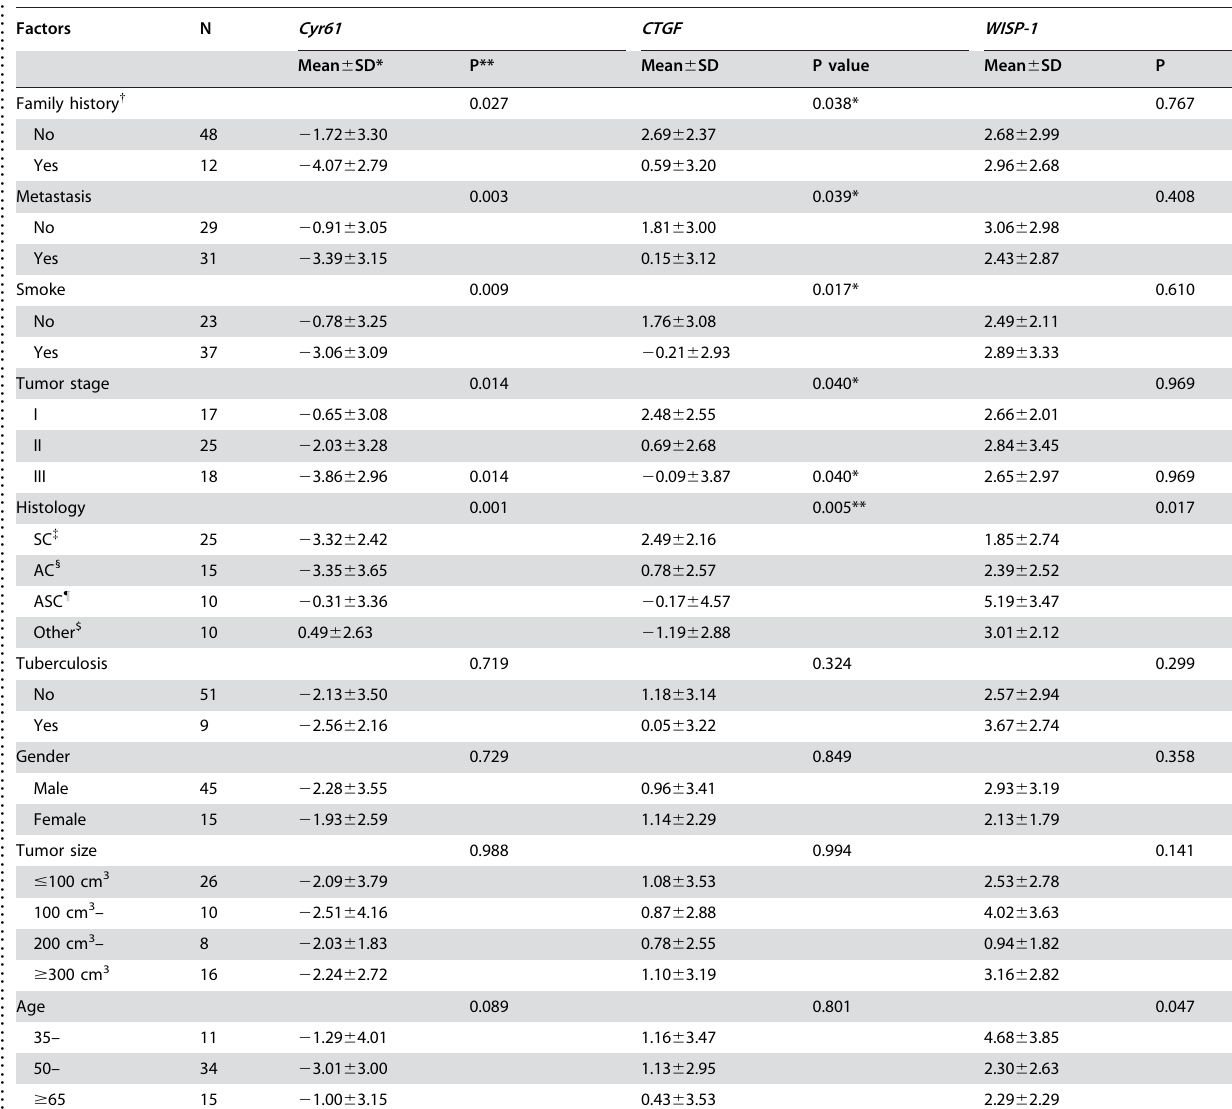
Table 3. Relationship between levels of Cyr61 , CTGF , and WISP-1 mRNA in lung cancer and the clinical and pathological features